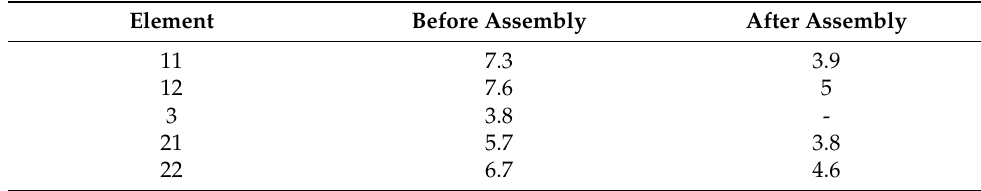
Figure 10. Experiment system. Table 2. Displacement response of motor at 100 V ( µ